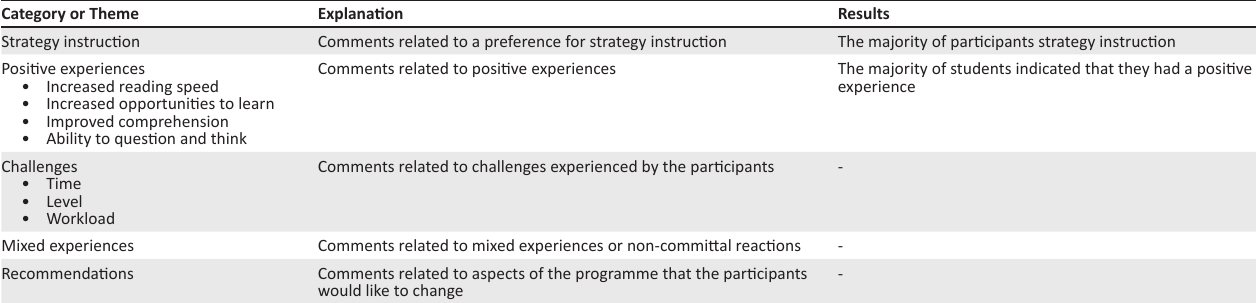
TABLE 3: Coding categories for open-ended